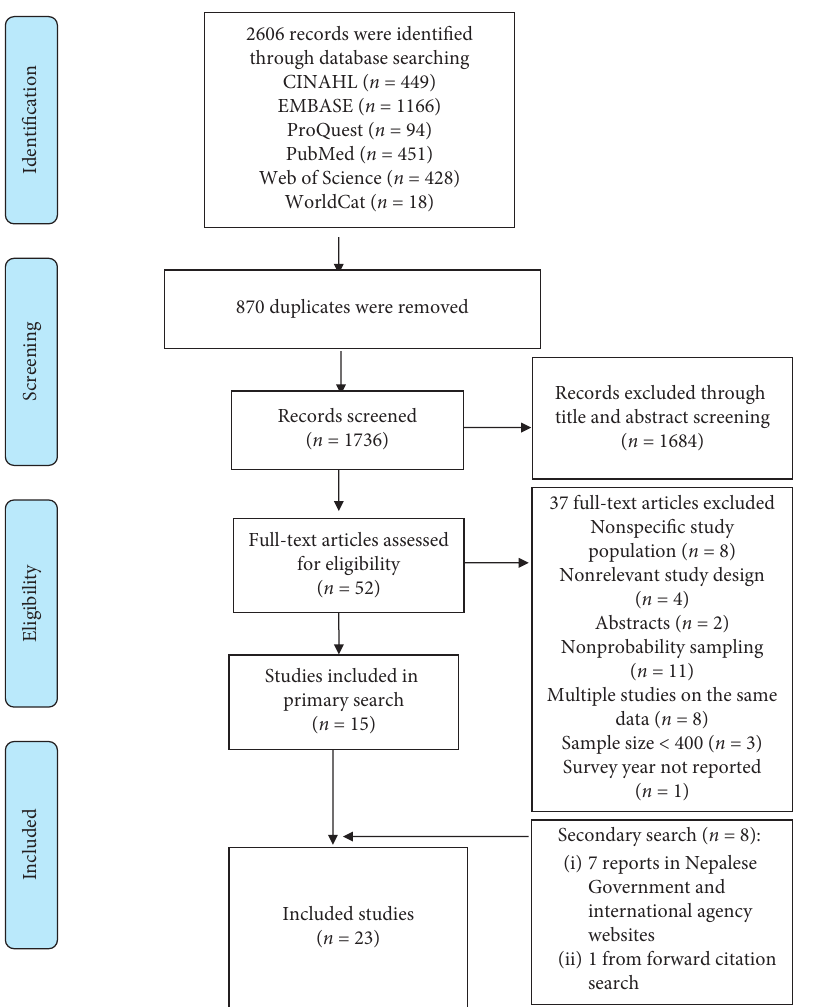
Figure 1: Study selection flow